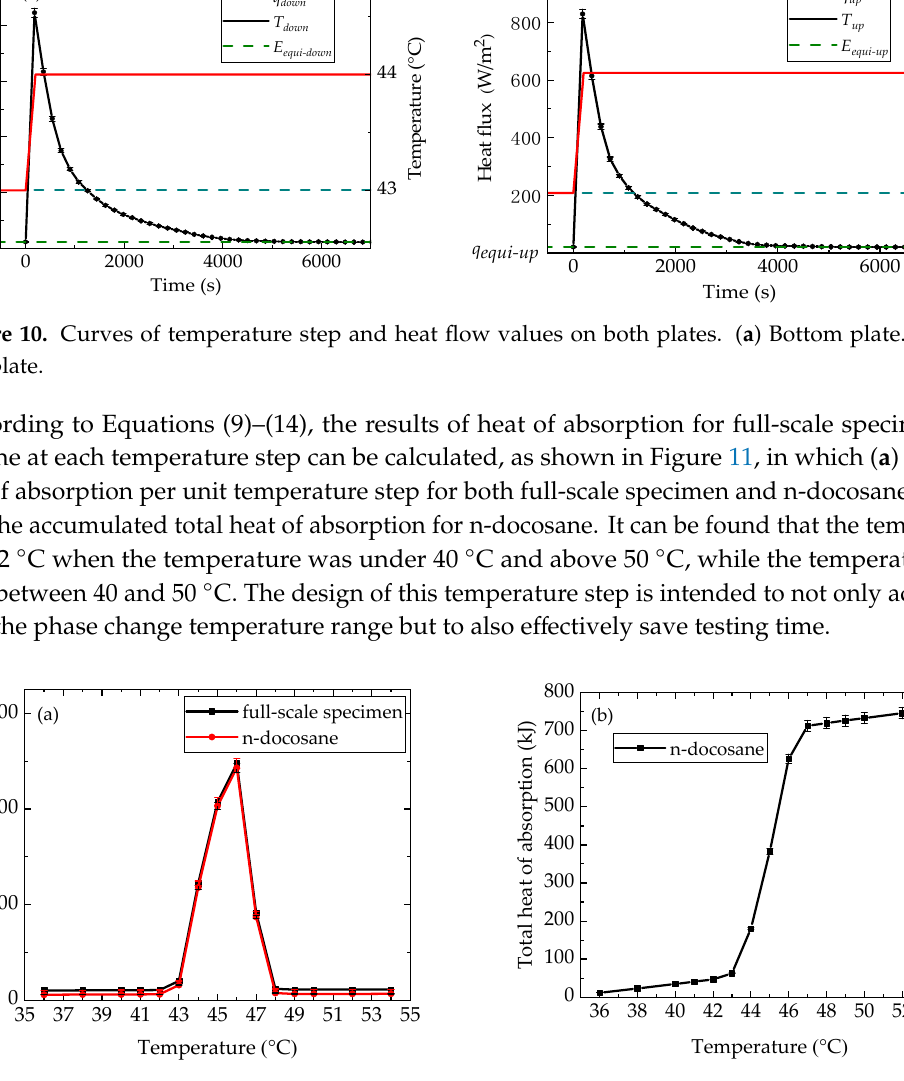
Figure 11. Testing results for heat of absorption of full-scale specimen and n-docosane. ( a ) Heat of absorption per unit temperature step. ( b ) Total heat of absorption.